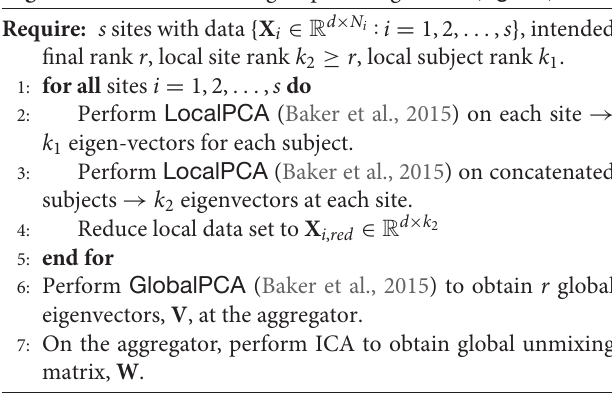
Algorithm 6 Decentralized group ICA algorithm ( dgICA